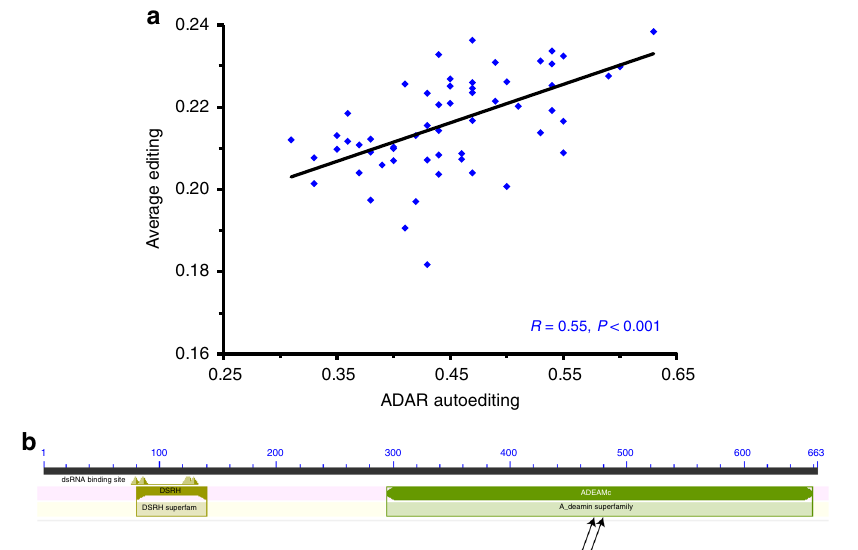
Fig. 3 ADAR autoediting is weakly but positively correlated with overall RNA editing. a The plot shows Pearson ’ s correlation between the editing levels at 2609 coding and non-coding sites with a median coverage ≥ 50 reads and the BtADAR autoediting level at site Group15.5:2877069 (position 482 on the protein sequence). Source data are provided as a Source Data fi le. b The arrows point to the location of the two non-synonomous editing sites within